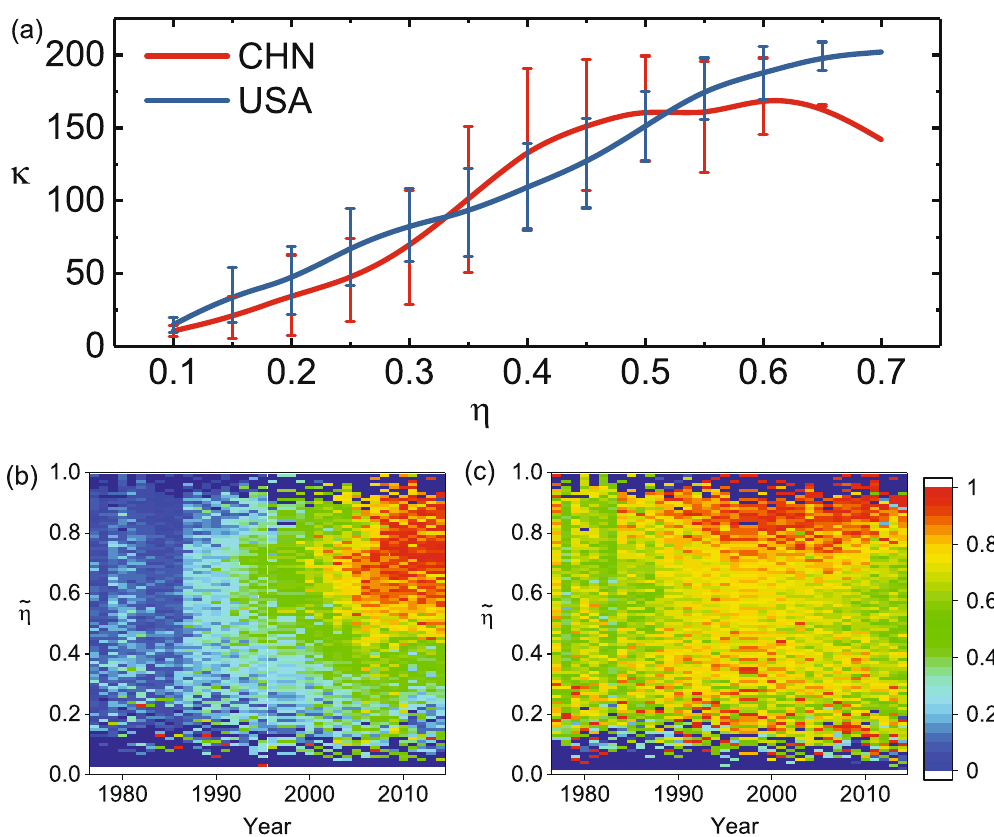
Fig. 4 Quantifying trade competitive of countries. a Quantifying trade competitive of three countries with different nested product networks. The curves stand for the United States (USA), China (CHN). b , c The evolution of trade competitive with the nested products for China ( b ) and the United States ( c ). If the normalized trade competitive is closer to 1, the country has stronger trade competitive. The heatmap depicts the evolution of trade competitiveness with high-nested products corresponding to normalized